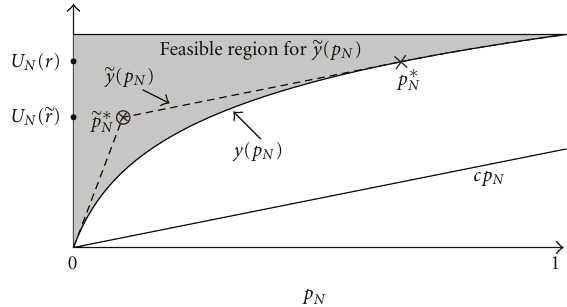
Figure 2: An illustrative example of using intervention to suppress malicious